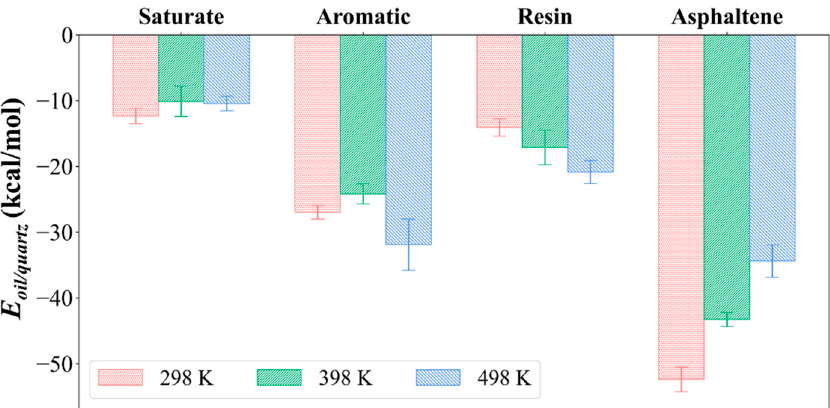
Figure 14. The E oil/quartz of single saturate, aromatic, resin, and asphaltene molecules in nanopore at 298 K, 398 K, and 498 K, respectively (the minus means attraction, and the error bars are generated by time averaging).